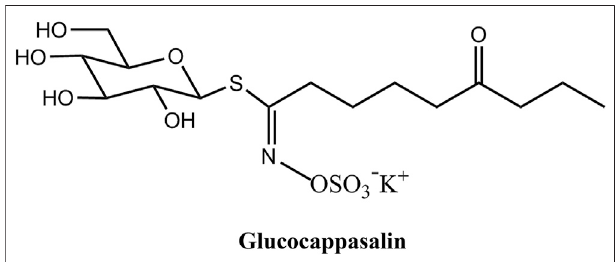
FIGURE 1 | The chemical structure of Glucocappasalin